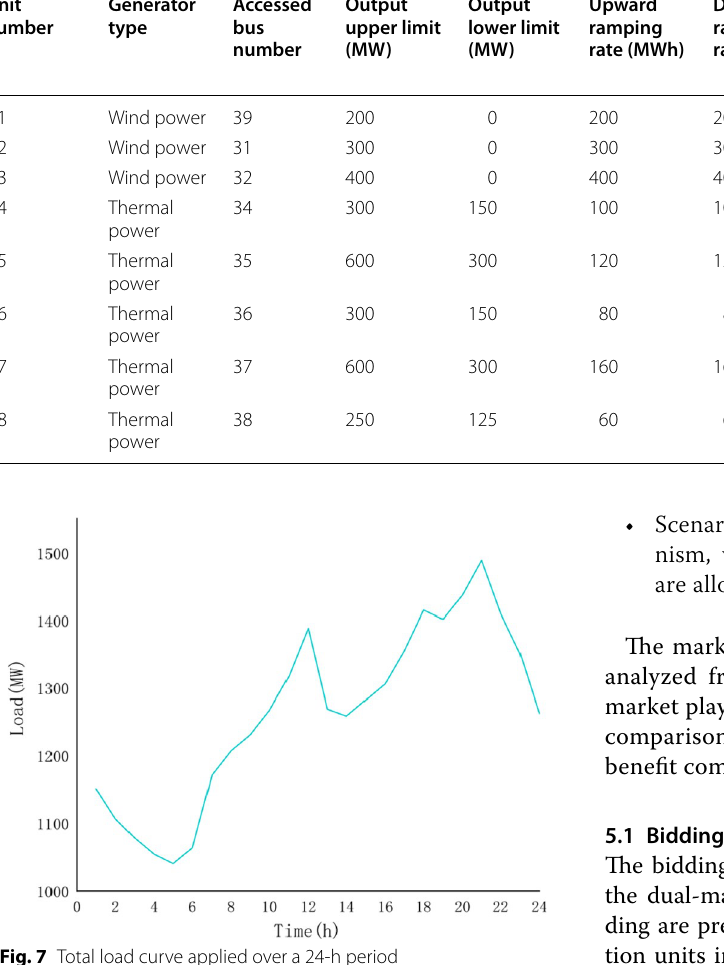
Table 1 Basic data of the improved system Unit Generator number type